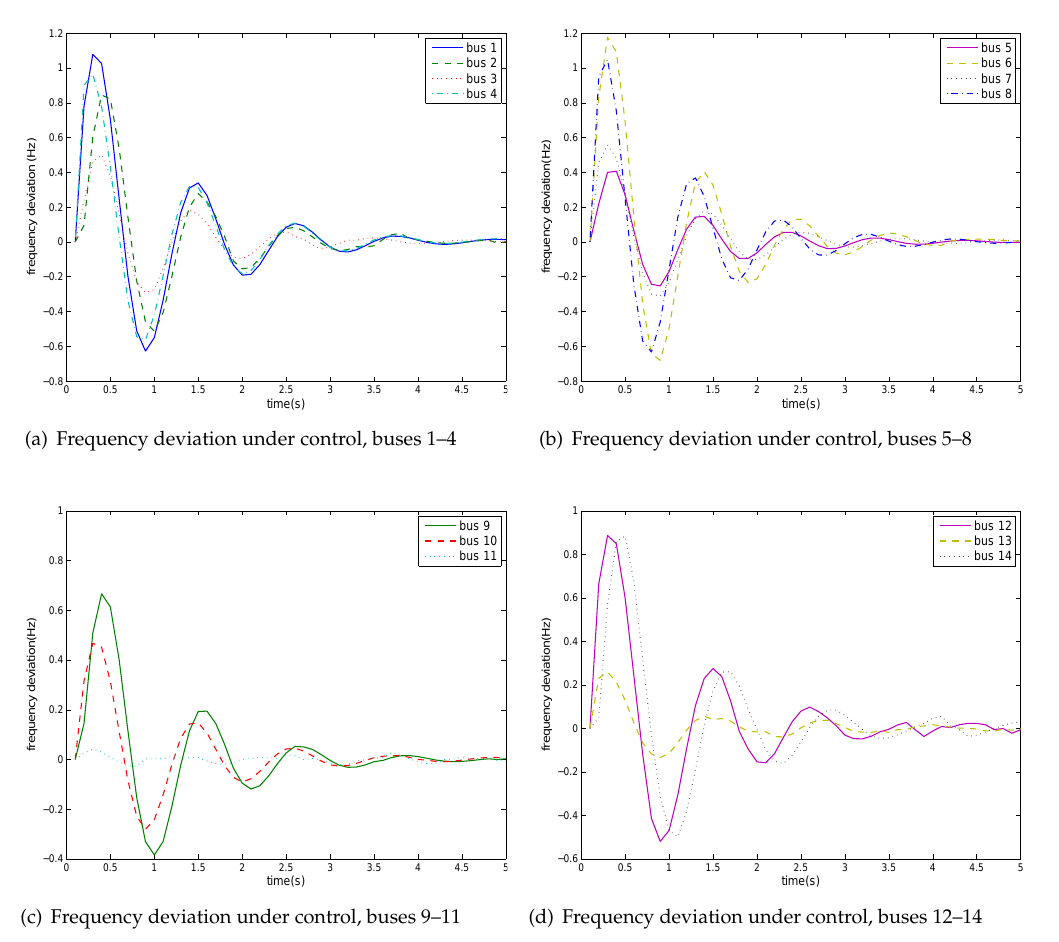
Figure 4. Frequency deviation of IEEE 14 bus system under control.